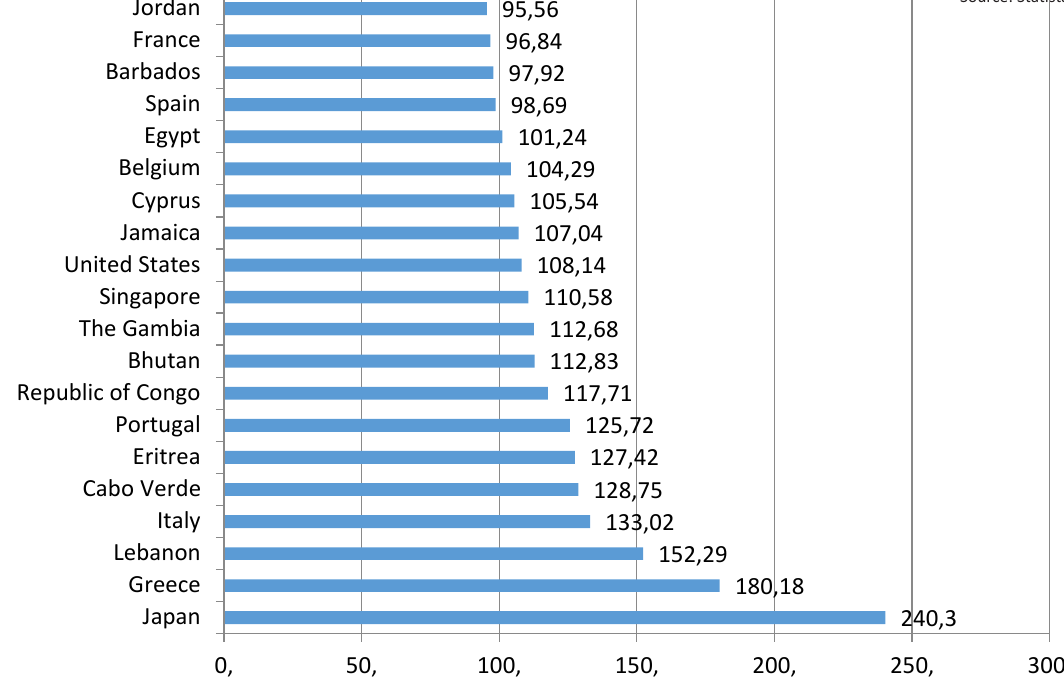
Figure 2. Countries with the highest debt-to-GDP ratio in the world,